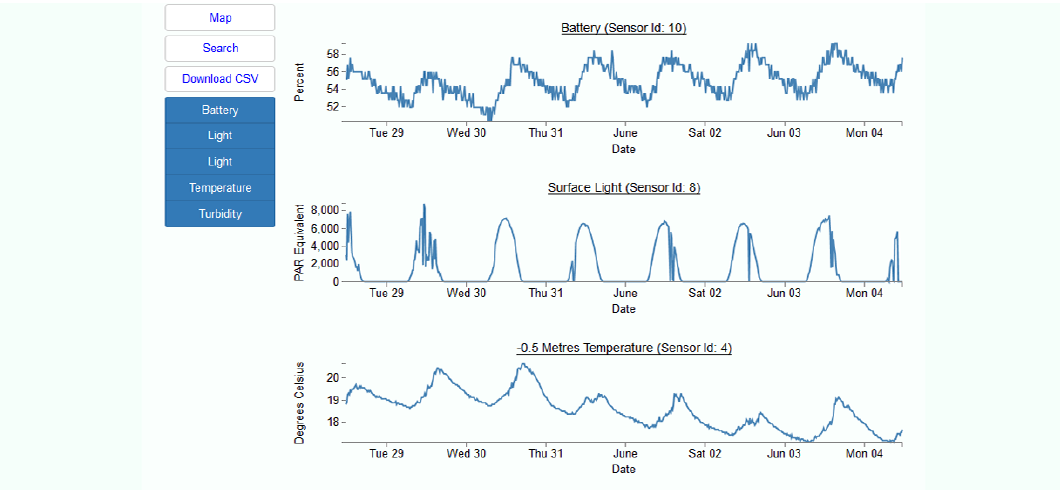
Figure 7. Web-Based User Interface.